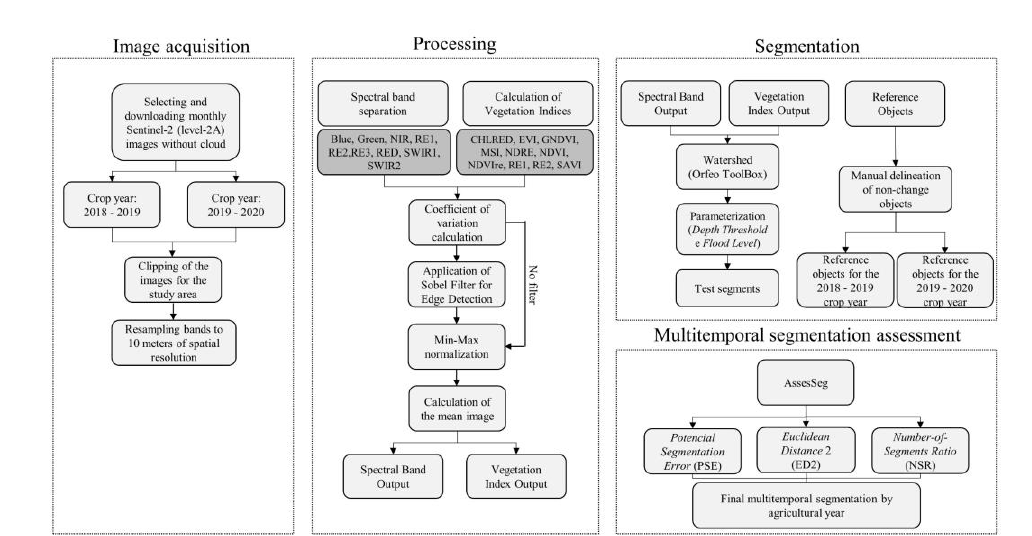
Figure 2. Methodological workflow for multitemporal segmentation of Sentinel-2